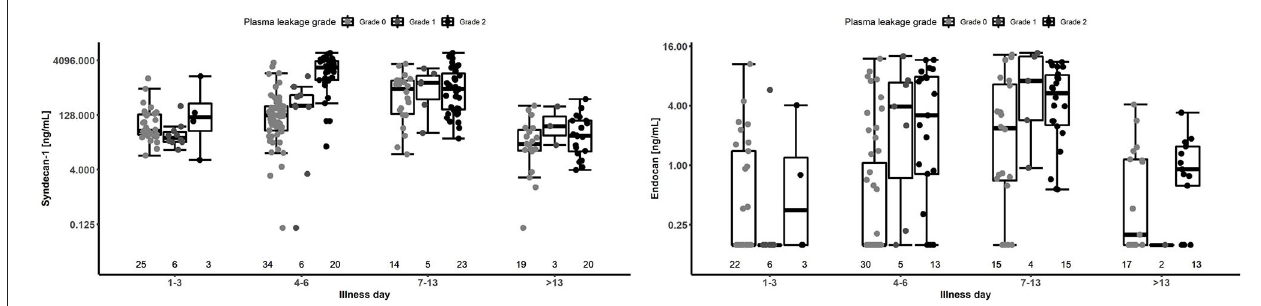
FIGURE 5 | Boxplot of plasma SDC1 and endocan measurements by illness day and plasma leakage grade for patients with laboratory confirmed dengue. Dots represent individual values of SDC1 and endocan in each group. The number below represents the number of patients that contributed to each group. The SDC1 graph is based on 70 patients contributing 209 measurements, and the endocan graph is based on 57 patients contributing 169 measurements. Values below the limit of detection for Endocan were imputed as 0.156 ng/mL (detection limit) in this analysis.